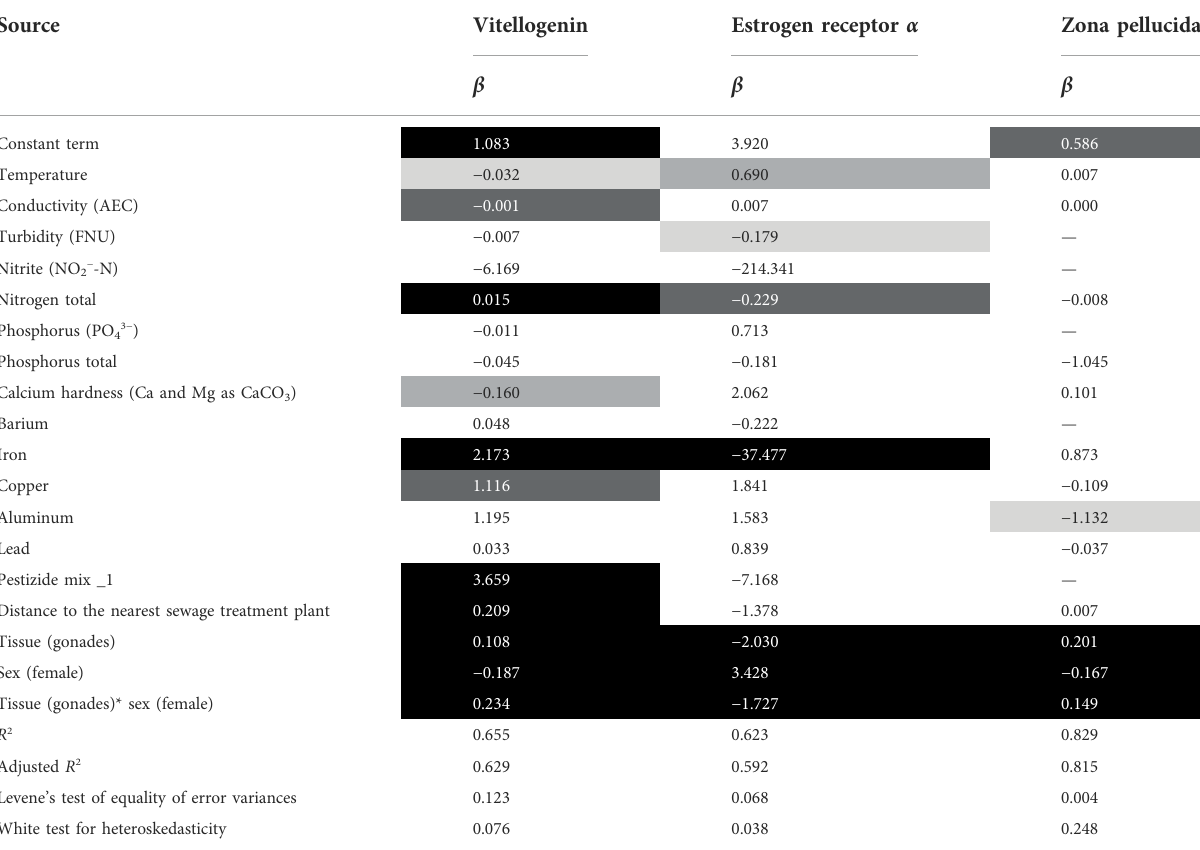
TABLE 2 Statistical results of GLM models to the effects of tissue and sex (factors) and chemical and physical water parameters, as well as pesticide mix (as covariates) on the expression levels of vitellogenin, estrogen receptor α and zona pellucida. Signi fi cant correlations and interactions based on type III Wald statistics are highlighted